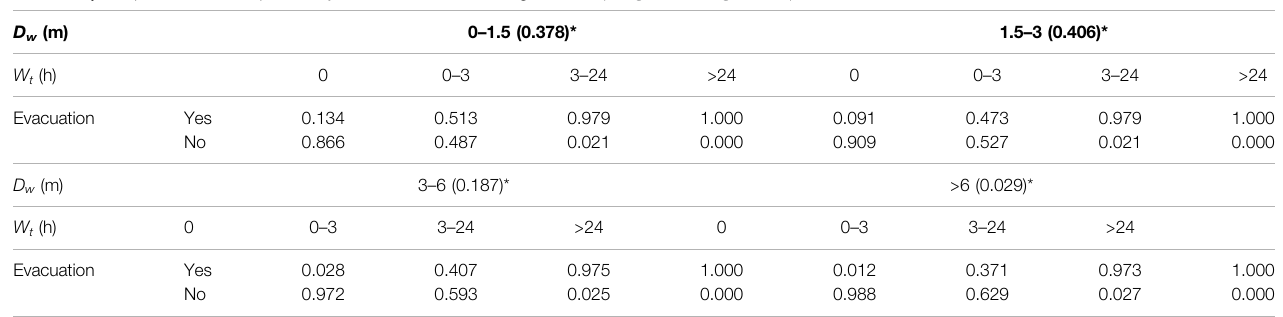
TABLE 1 | The prior conditional probability table of evacuation using HURAM (Peng and Zhang,